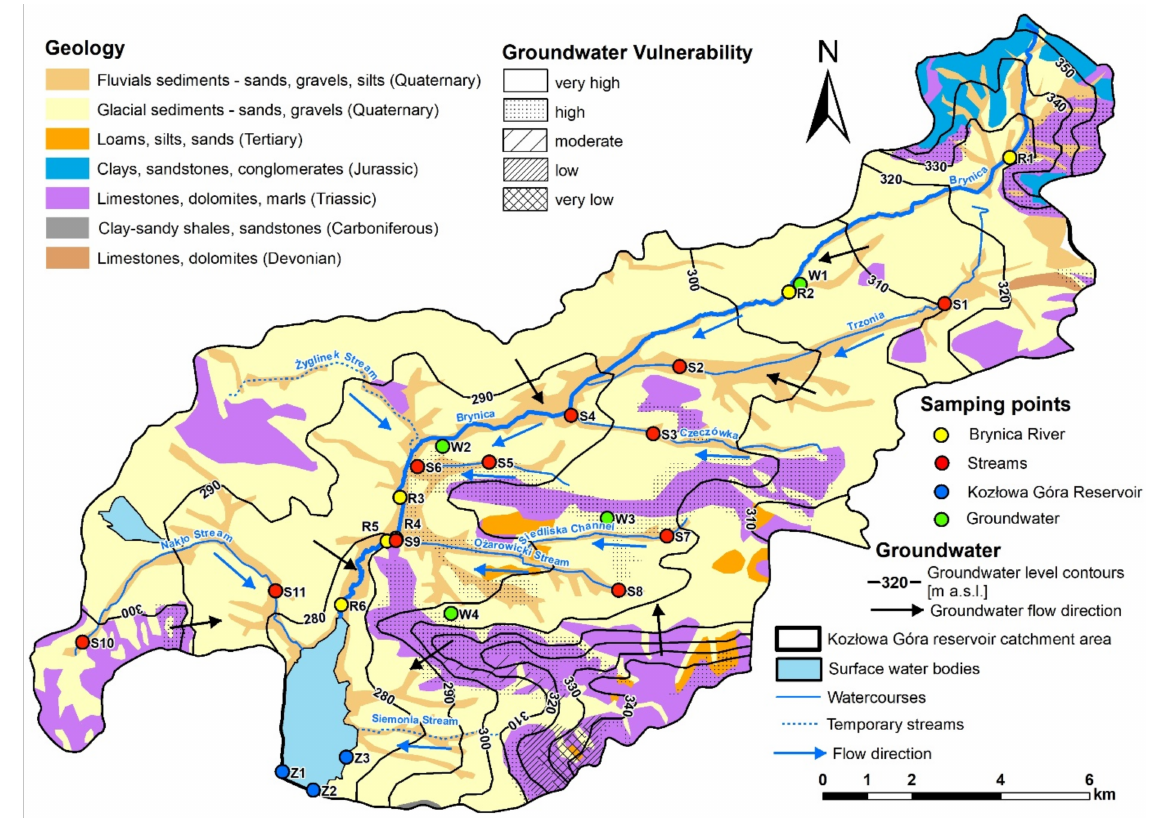
Figure 2. Geology and hydrogeological conditions of the study area based on